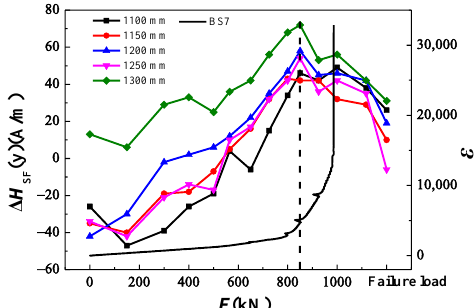
Figure 13. ∆𝐻 SF (y) - F relationship curves of the top flange: ( a ) non-SCZ location; ( b ) SCZ location.